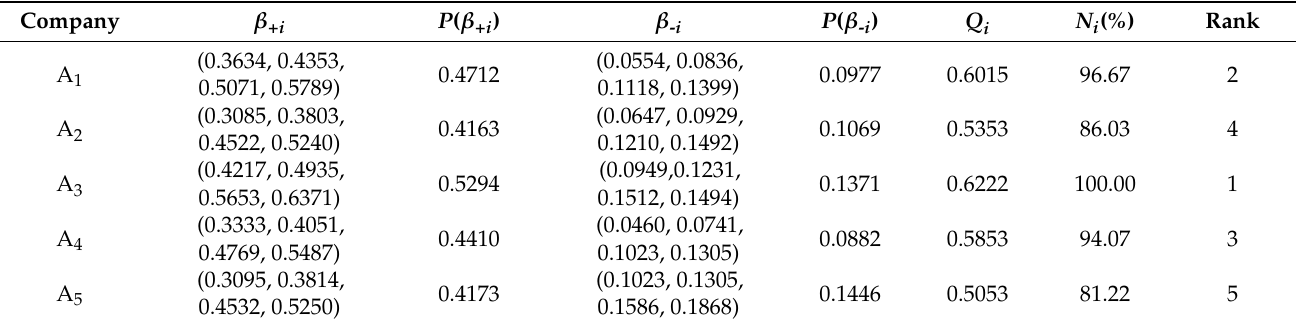
Table 9. Final results and ranking orders.